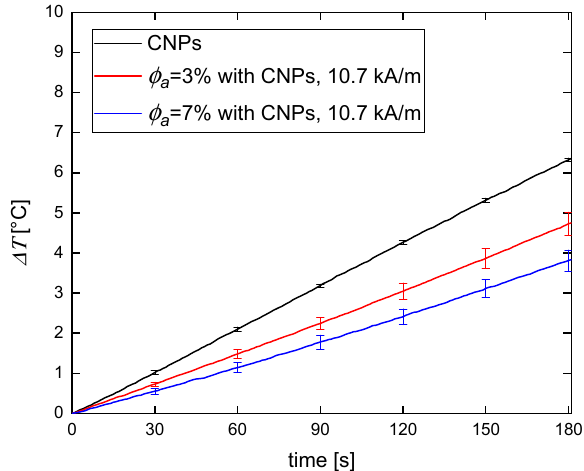
Figure 6. Temperature increase for CNPs suspended in water and embedded in 3% and 7% agar phantom for 10.7 kA/m of the magnetic field.